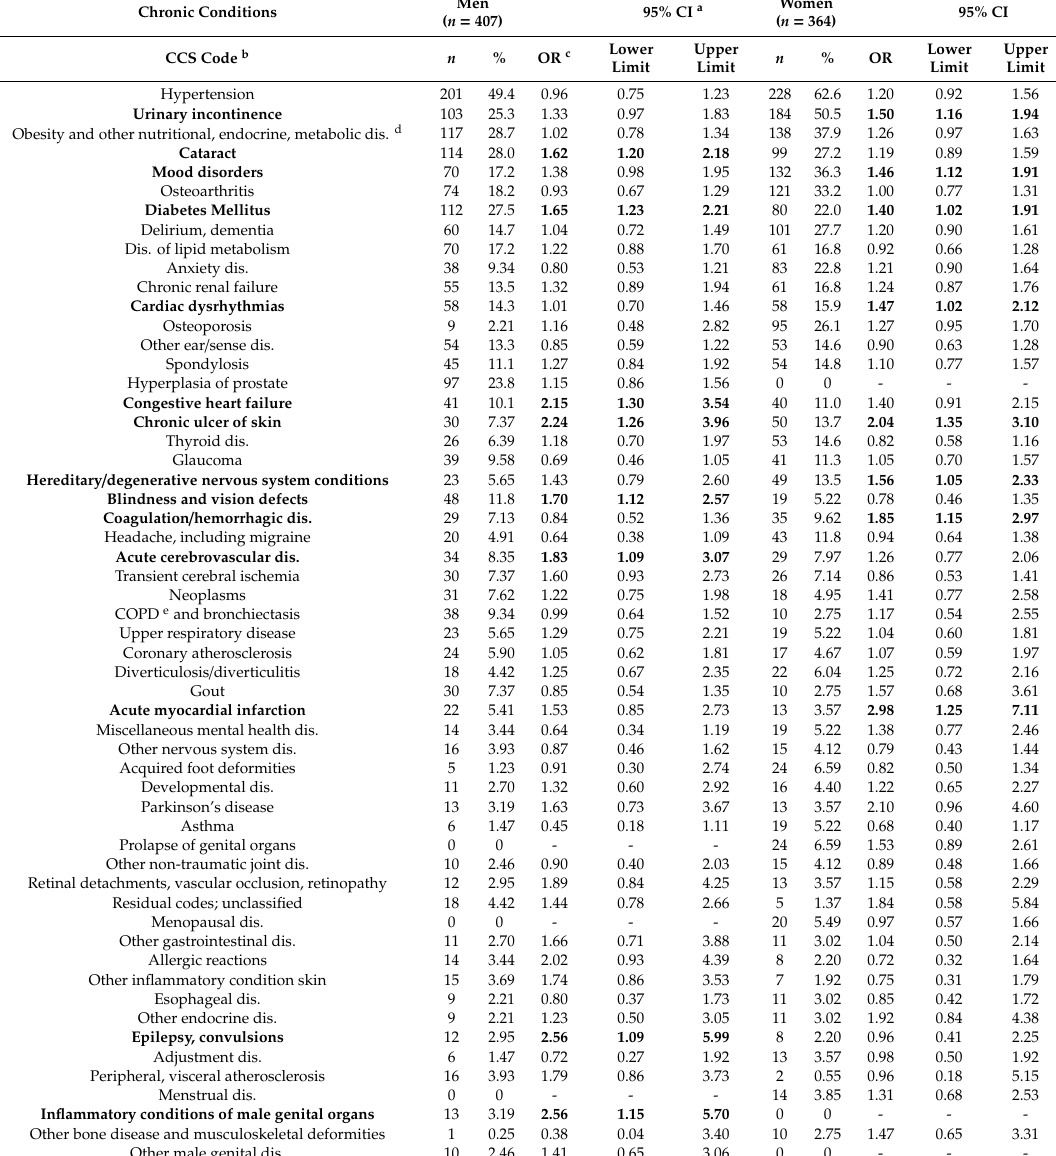
Table 2. Prevalence of chronic diseases at cohort entry of individuals that died during the follow-up period, and association with all-cause mortality, by